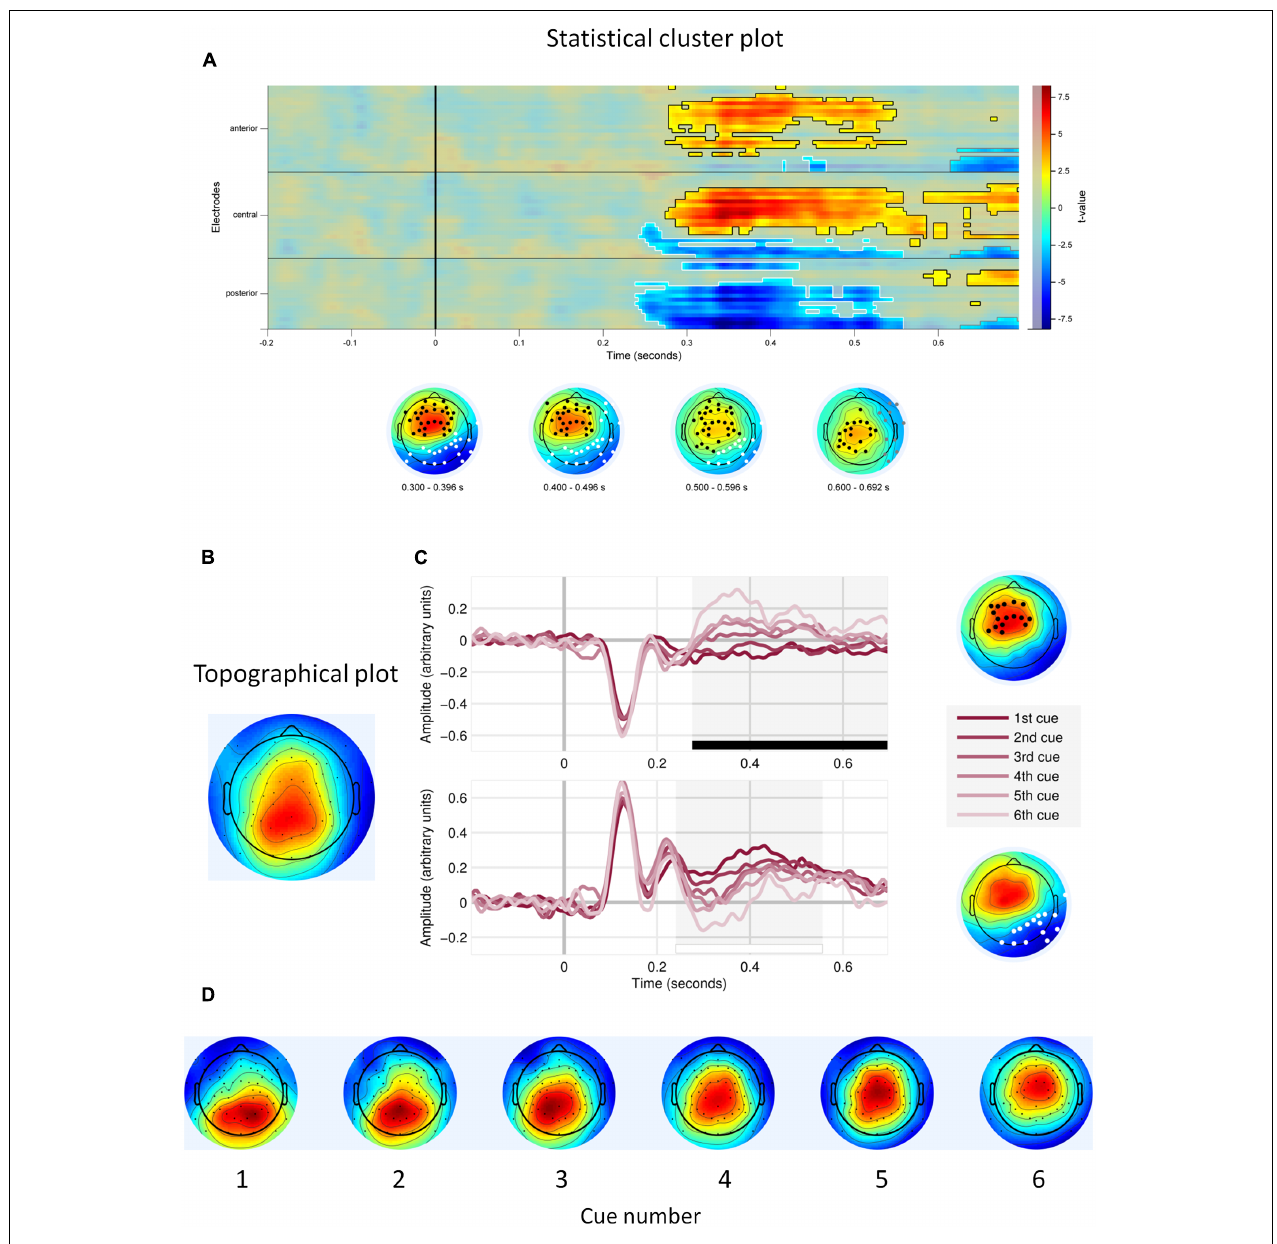
FIGURE 3 | Main effects of cue number. (A) Statistical cluster plot for the cue number effect with significant electrodes, scalp and time location. (B) Topographical plot of the P3 component (time window 300–400 ms), averaged across participants, trials and cues. (C) Event related potentials in response to each decision cue, at the frontal cluster (Upper) and at the parietal cluster (Lower). (D) Topographical plots of P3 responses (time window 300–400 ms) to consecutive decision cues, averaged across participants and